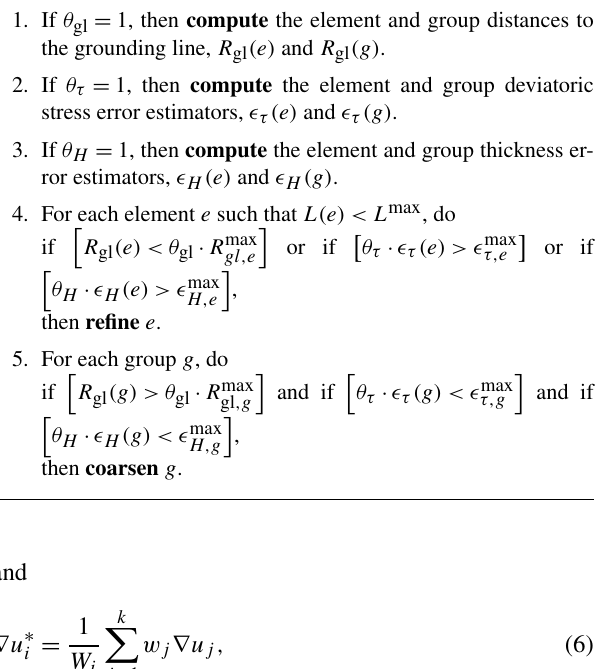
Algorithm 2 AMR core: refinement criteria calculation, re- finement and coarsening processes. e = element; g =